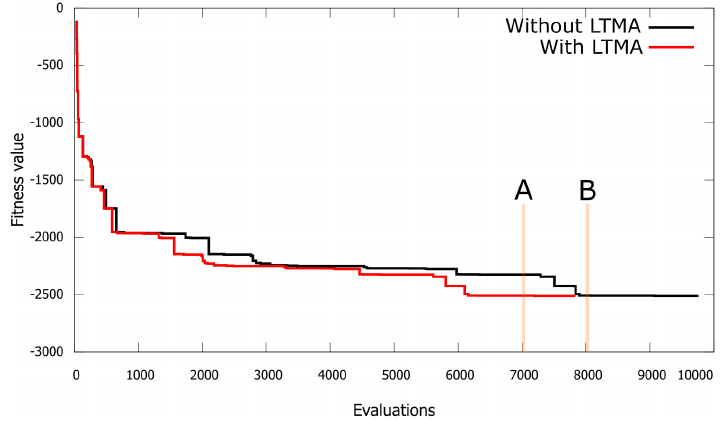
Figure 1. Convergence graph of the ABC algorithm with the Long Term Memory Assistance